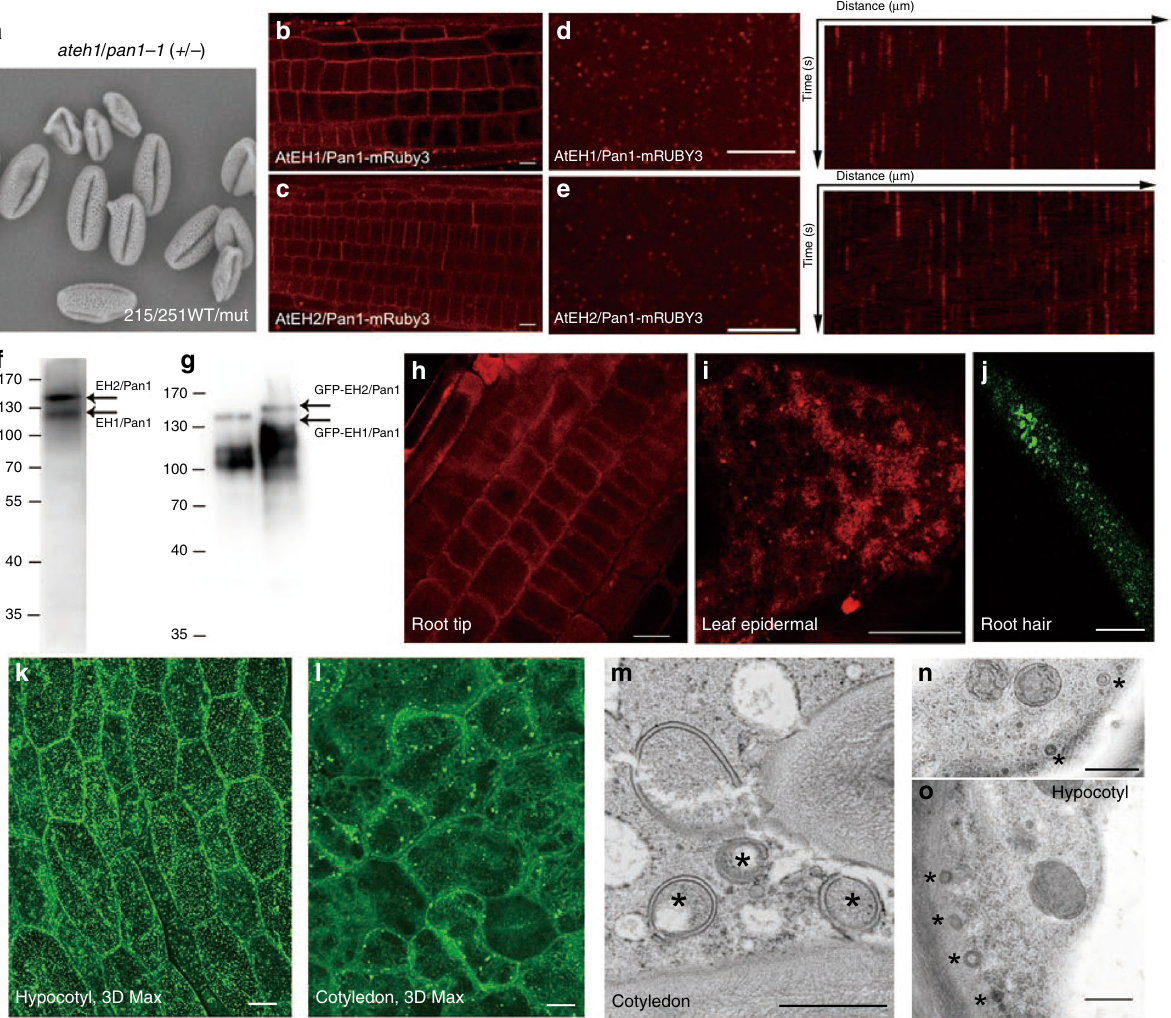
Fig. 2 AtEH/Pan1 localize to the PM as well as to punctate structures that are likely to be autophagosomes. a Representative SEM image of pollen from a heterozygous ateh1/pan1-1 plant showing normal and shrivelled pollen in a 1:1 ratio. b – e In the Arabidopsis root ( e , f ) and hypocotyl cells ( l , m ), AtEH/Pan1- mRuby3 proteins, in their respective complemented mutant background, localize predominantly to the PM at dynamic endocytic foci. To some extent, discrete larger punctae can be observed. f , g An antibody raised against AtEH2/Pan1 recognizes both proteins in Arabidopsis seedlings ( g ) and recognizes GFP-AtEH/Pan1 fusions transiently expressed in N. benthamiana . h – j Immunolocalization using the anti-AtEH/Pan1 antibody con fi rms the PM localization in Arabidopsis root cells and also identi fi es punctate labelling in leaf epidermal and root hair cells (Scale bar: 10 μ m). k – o Punctate structures were identi fi ed in cells of Arabidopsis hypocotyl and cotyledons stably transformed with GFP-AtEH1/Pan1 ( k , l ). The same samples were further analysed at the ultrastructural level, and numerous double membrane autophagosome-like structures were identi fi ed ( m – o ; Scale bar: 500